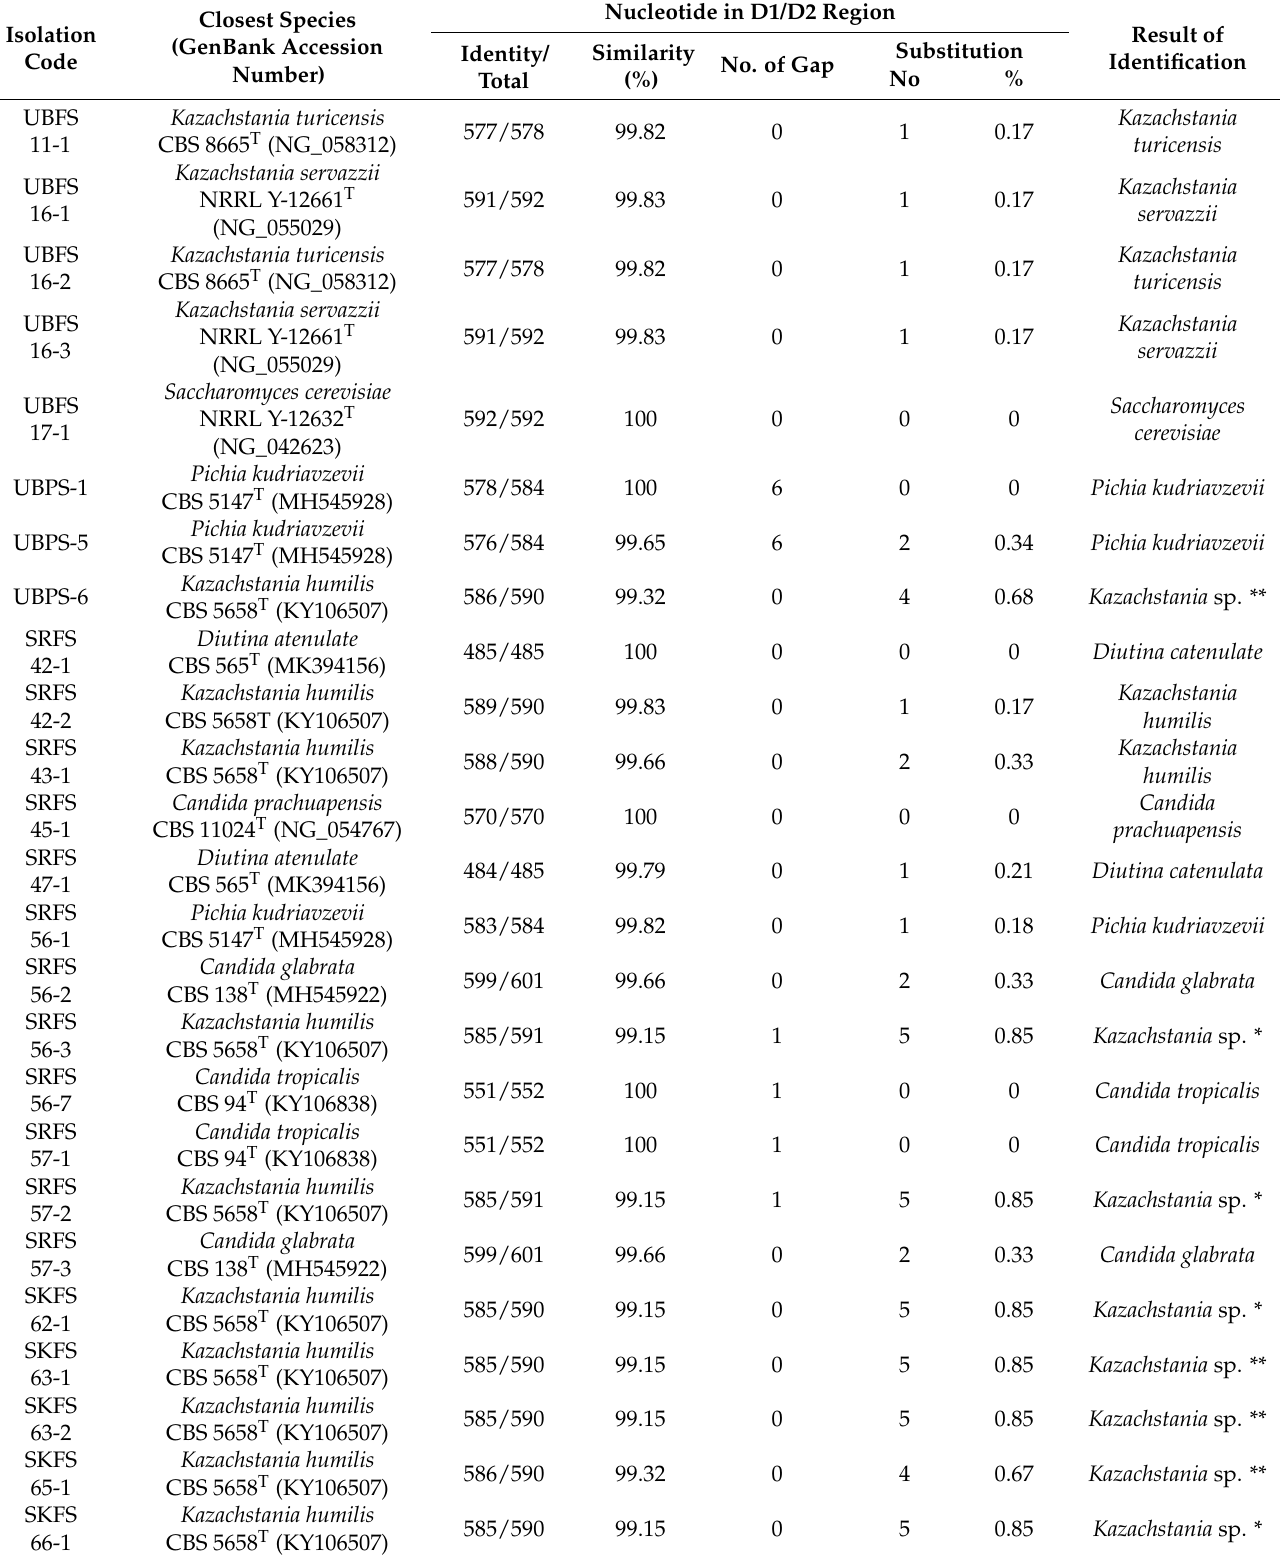
Table 4. Molecular identification of yeasts isolated from Plaa-som samples collected from fresh markets in